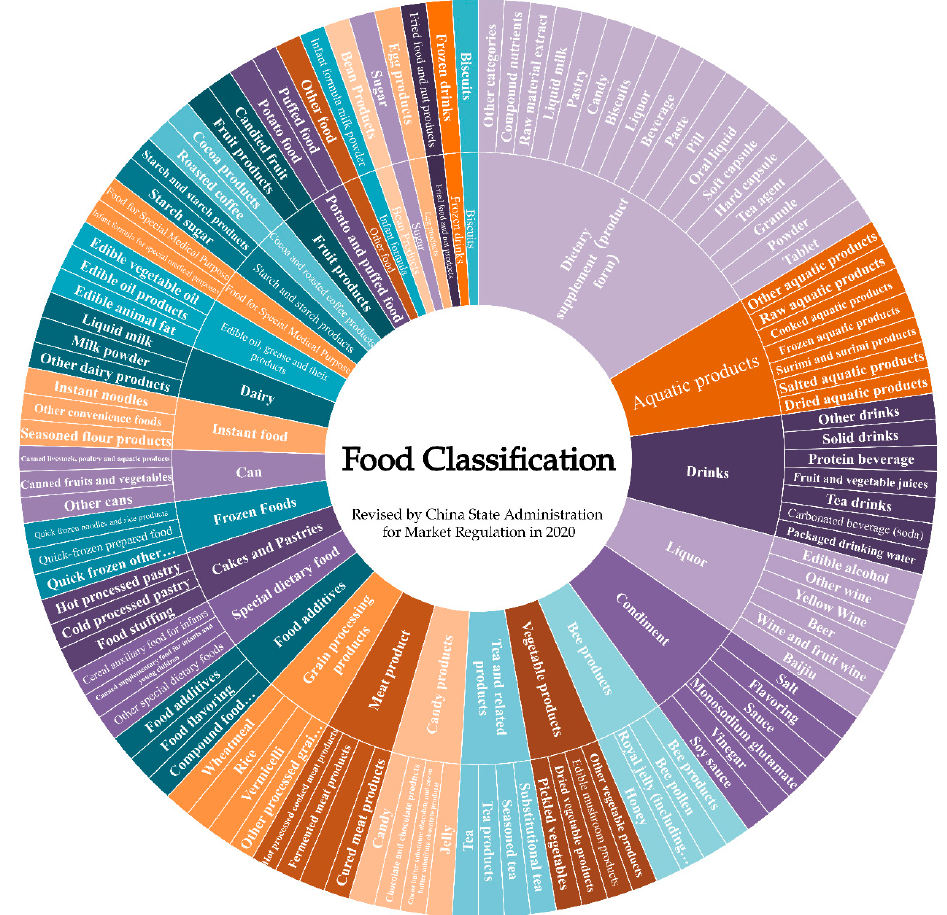
Figure 2. Sunburst chart of food classifications (The classified catalogue of food production licenses